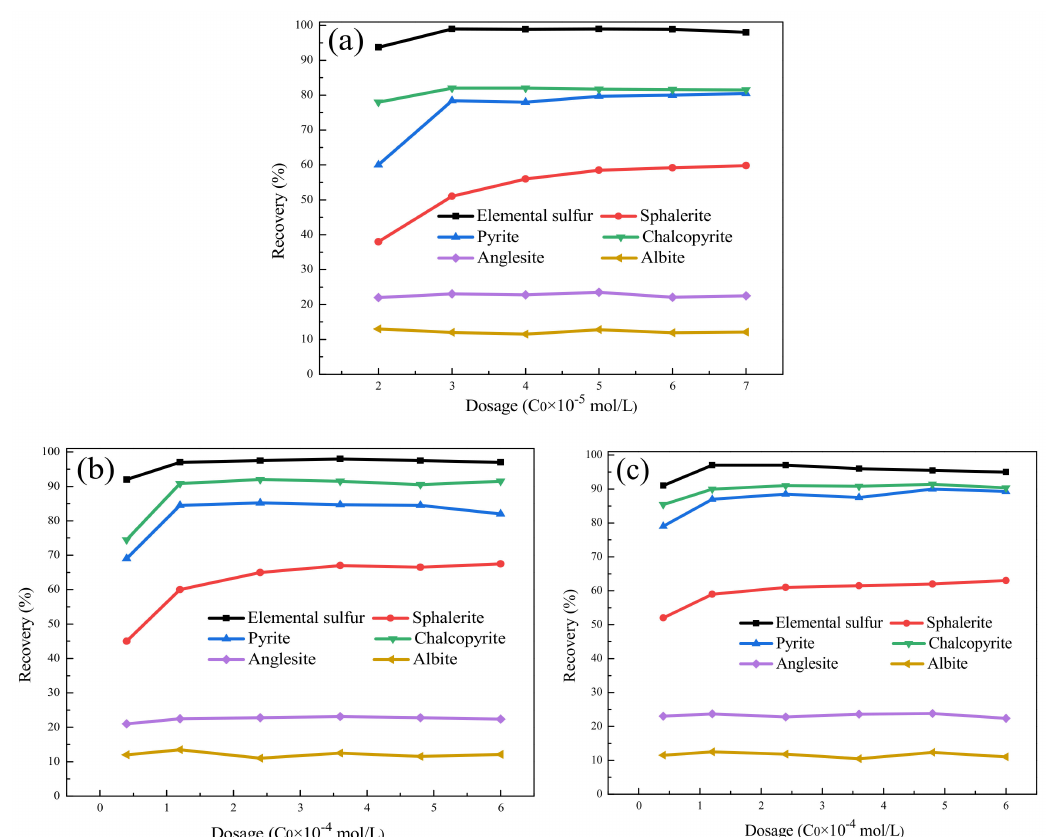
Figure 3. Effect of collector dosage on pure mineral recovery at pulp pH value 8 (( a ) IPETC; ( b ) ADDTP; ( c ) SEX).